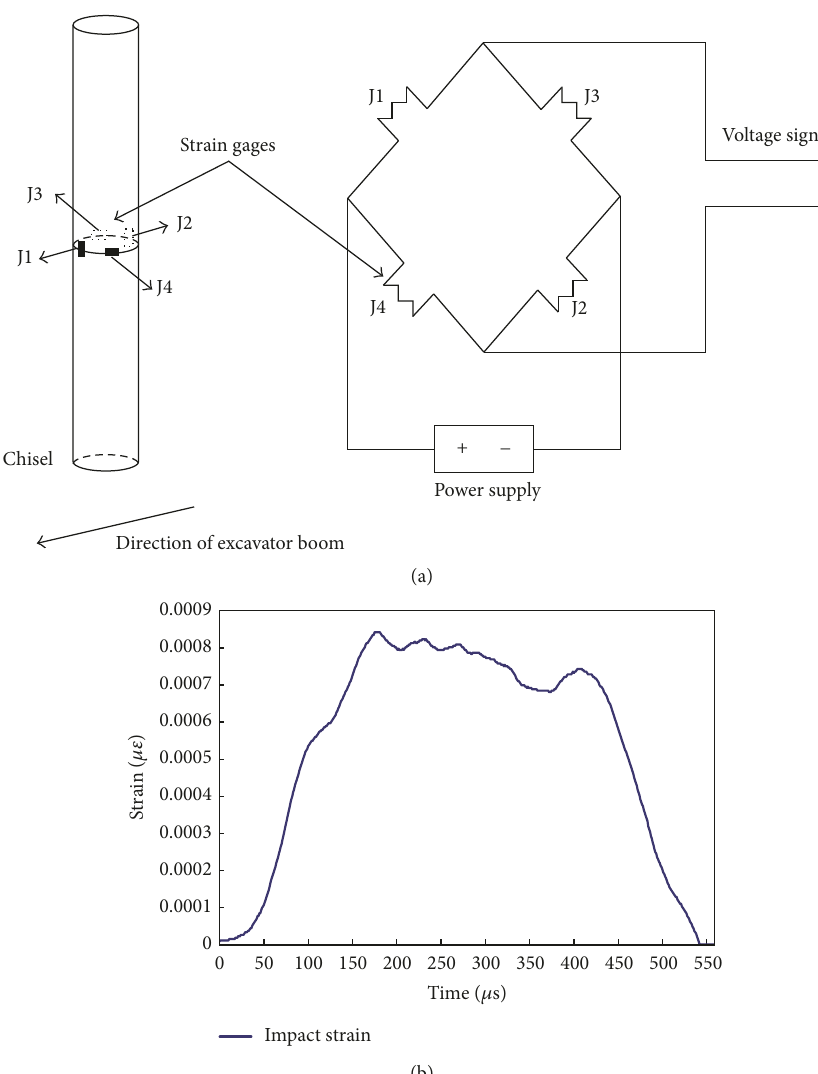
Figure 9: Impact energy measurement: (a) setup of the strain gauges, (b) shock wave profile of impact energy strain.